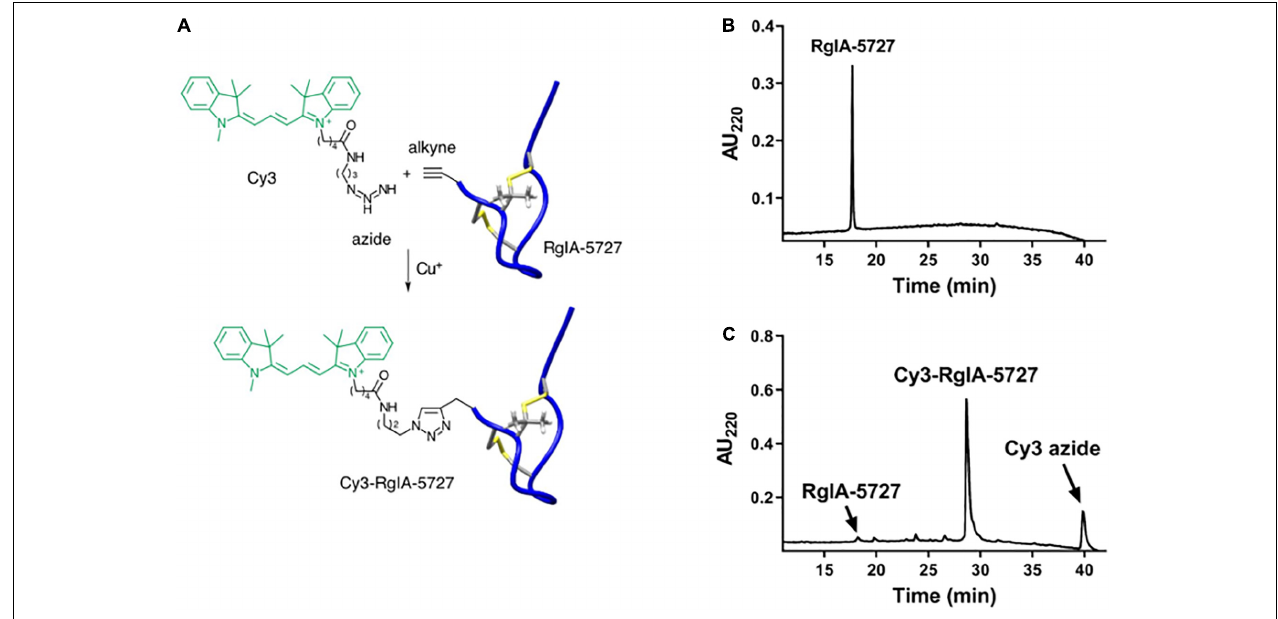
FIGURE 1 | Synthesis and HPLC purification of Cy3-RgIA-5727. (A) The N-alkyne-containing RgIA analog was reacted with Cy3-azide, in the presence of Cu (I) as a catalyst, to form Cy3-RgIA-5727. (B) Chromatography profile of alkyne-bearing precursor RgIA-5727. (C) Chromatography profile of the crude click reaction mixture. The major peak corresponds to the desired product,